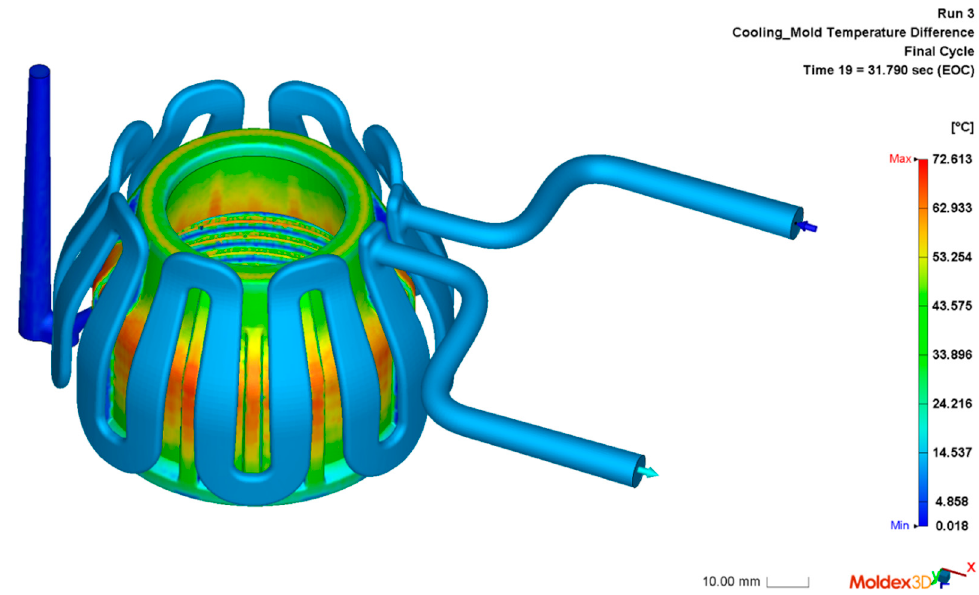
Figure 12. Temperature measurements with infrared thermal camera after ejection demonstrating the temperature reduction in mould insert’s cavity when applying conformal cooling (top left) compared to conventional cooling (top right) and simulated temperatures with conformal cooling by means of FEA immediately after ejection with average temperature in the cavity of 36.6 °C (bottom).